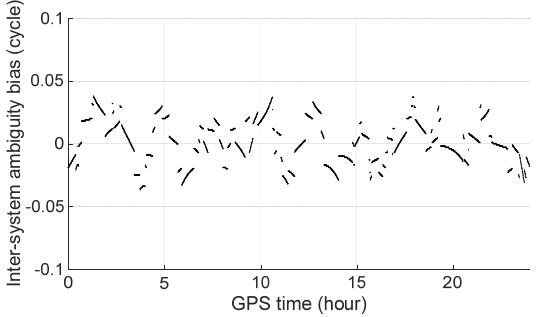
Figure 8. Bias of the inter ‐ GNSS wide ‐ lane ambiguity resolution by neglecting tropospheric delay.